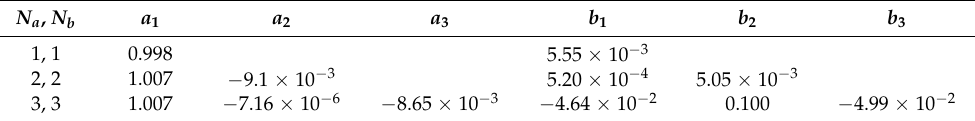
Table 3. The ARX model parameters for model orders 1, 2, and 3 (control interval of 15